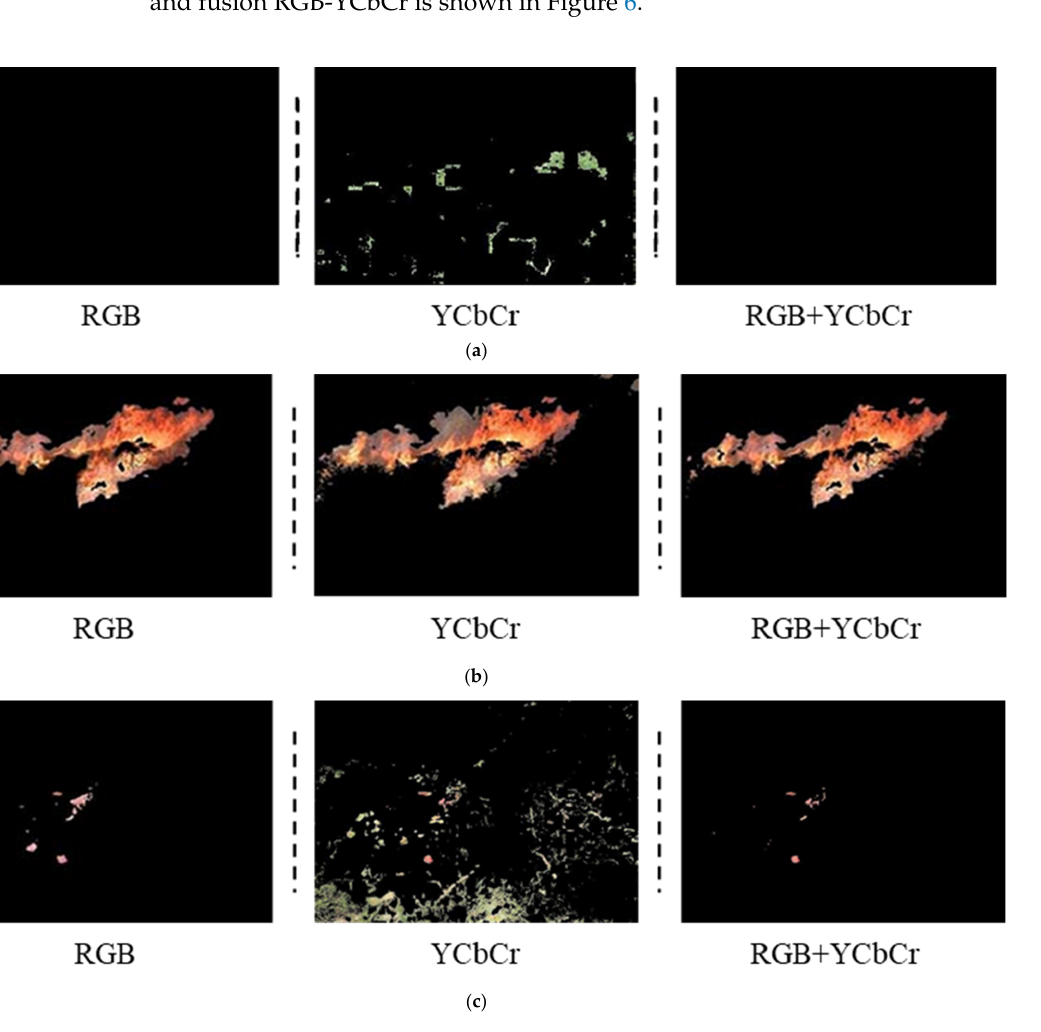
Figure 6. Comparison of RGB, YCbCr, and fusion RGB-YCbCr results: ( a ) extraction results of forest image without fire; ( b ) extraction results of forest image with fire; ( c ) extraction results of forest image with fire-like interference.